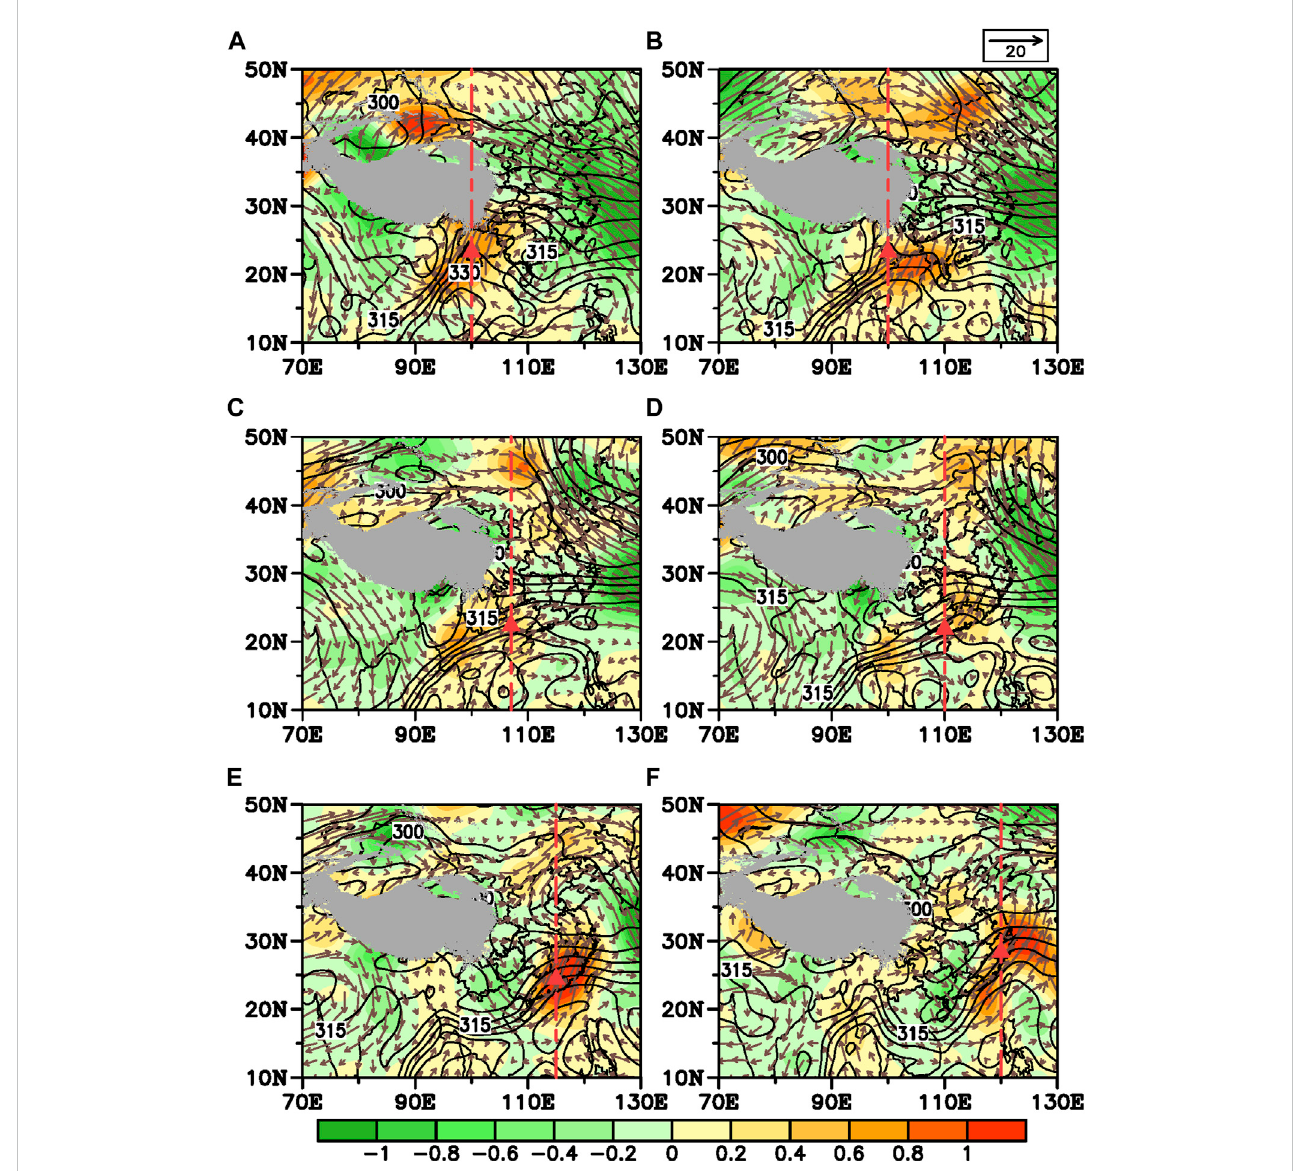
FIGURE 7 Equivalentpotentialtemperature(blackcontours;units:K),thewind fi eld(vectors;units:m s − 1 )andthetemperatureadvection(shading;units:10 – 4 K · s − 1 ) at 700 hPa on January (A) 8, (B) 9, (C) 10, (D) 11, (E) 12 and (F) 13 in 2015. The red triangle indicates the large-value center of the precipitation. The red dotted line shows the crossing line used for depicting the vertical cross-section pro fi les in Figures 11, 12. The gray shading shows the shape of the Qinghai-Tibetan